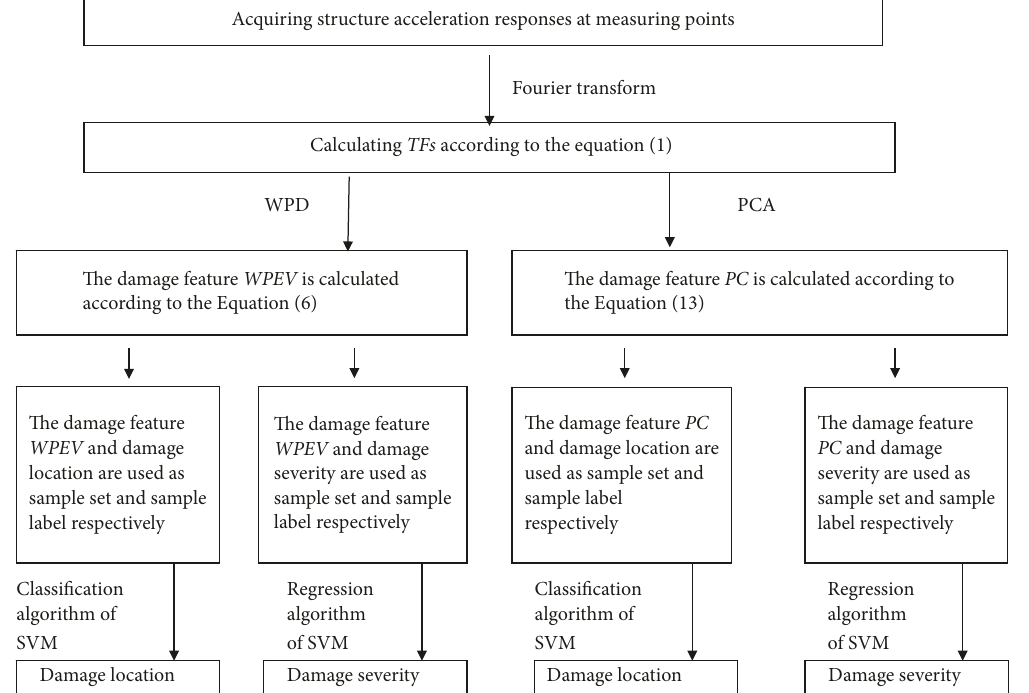
Figure 2: Flowchart of damage identification method based on TF and SVM.